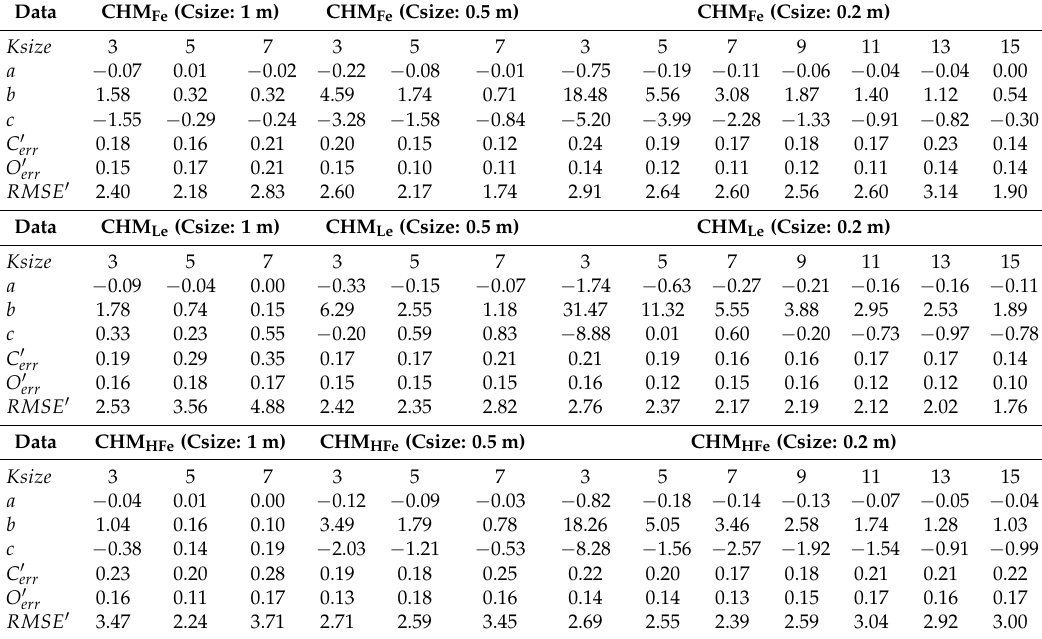
Figure 4. Quadratic regression models built using in-situ stand density measurements and LiDAR-estimated stand density from the local maximum method. ( a ) Csize = 1 m and Ksize = 3; ( b ) Csize = 0.5 m and Ksize = 5; ( c ) Csize = 0.2 m and Ksize = 11. Table 3. The error assessment results using regression models to correct stand density errors from three types of CHM (CHM Fe , CHM Le , and CHM HFe ) and three kinds of Csize (1, 0.5, and 0.2 m). Data